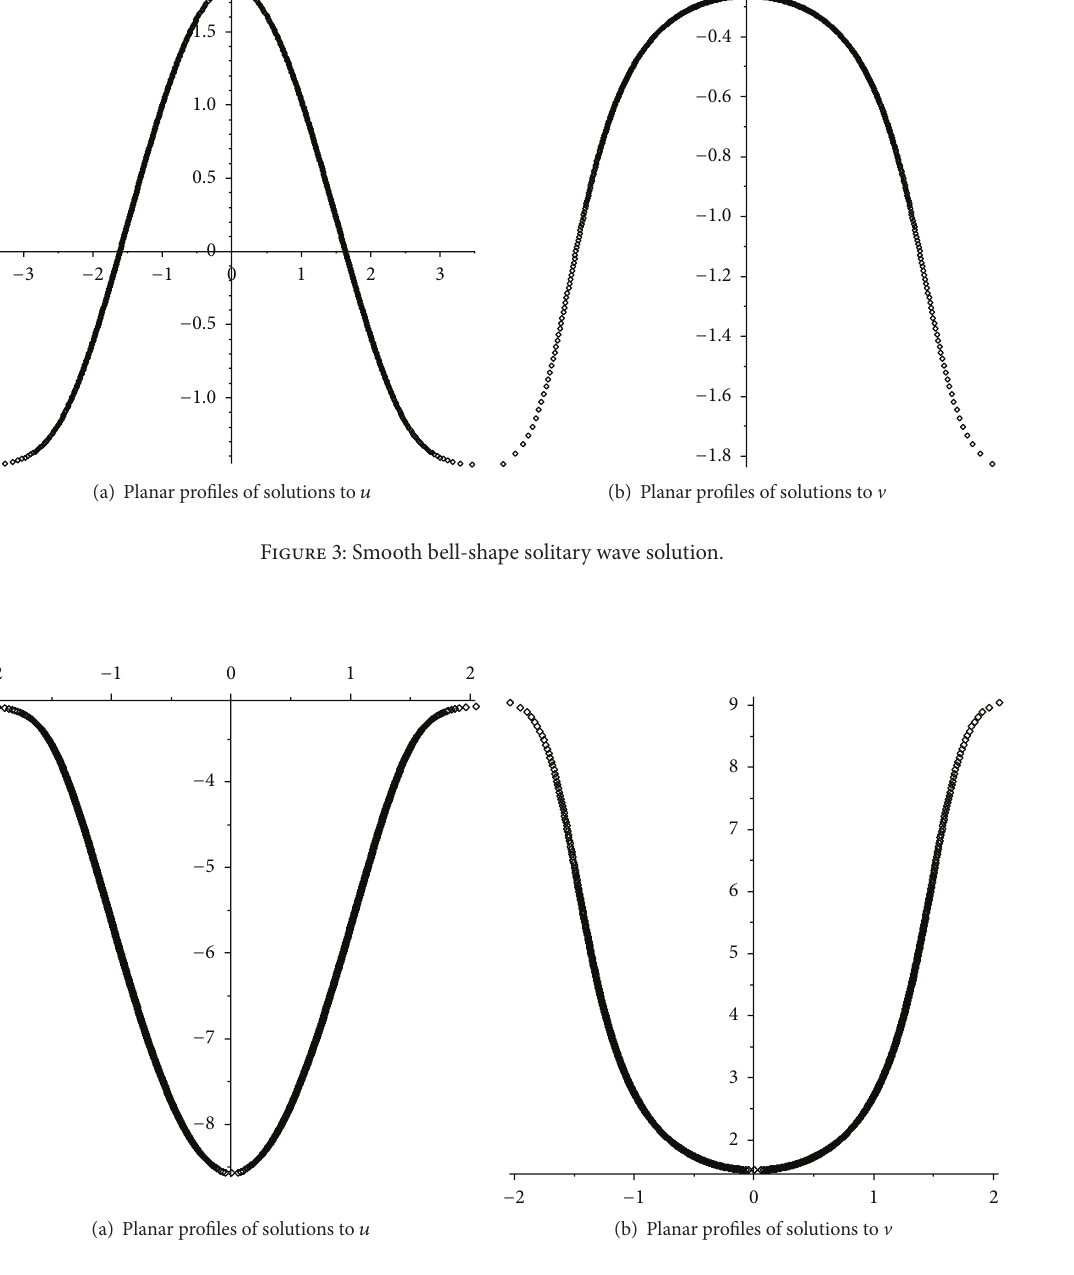
Figure 4: Smooth valley-shape solitary wave